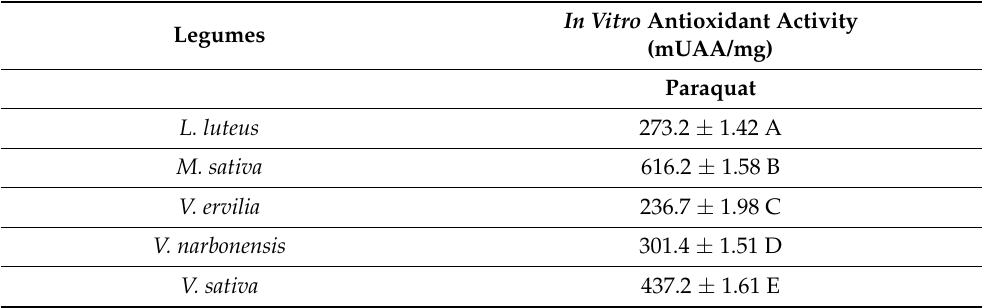
Table 5. Antioxidant capacity of protein hydrolysates from different legume species tested in the HT-29 cell line.